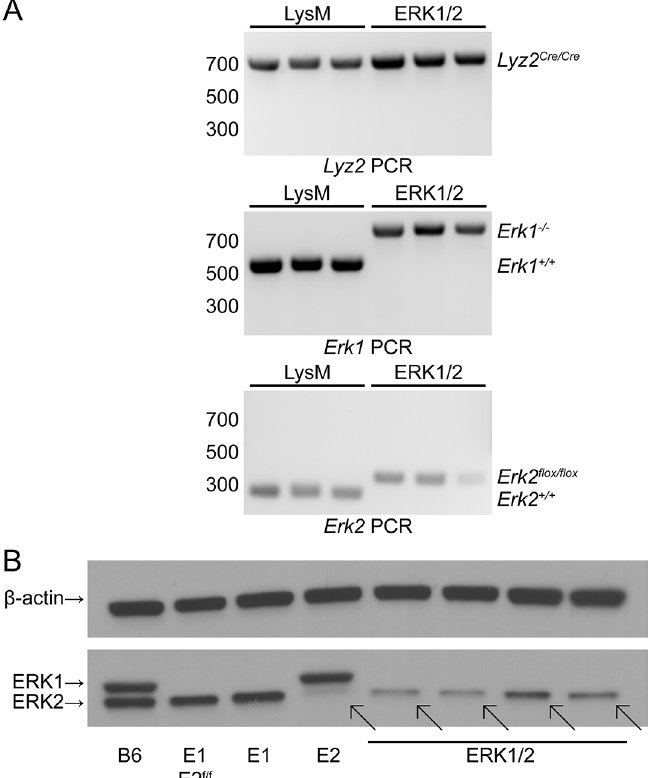
Fig 1. LysM and ERK1/2 mice express the expected mutations in germline DNA, but macrophages from ERK1/2 mice selectively retain expression of ERK2 protein. (A) DNA from clipped tails of LysM and ERK1/2 mice (three of each) was amplified to detect the mutant or wild-type alleles for Lyz2 , Erk1 , and Erk2 . (B) Macrophages were derived from bone marrow cultures stimulated for 7 d with LADMAC-conditioned medium containing M-CSF, and expression of ERK1 and ERK2 was detected by Western blotting. Diagonal arrows indicate the position of the ERK2 band, expressed in ERK1/2 macrophages but greatly reduced in Erk2 flox/flox Lyz2 Cre/Cre macrophages. Results are representative of three independent experiments. Labels: B6, C57BL/6J; E1 E2 f/f , Erk1 -/- Erk2 flox/flox ; E1, Erk1 -/- ; E2, Erk2 flox/flox Lyz2 Cre/Cre